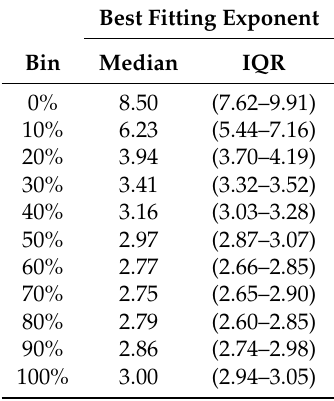
Table 1. Statistics of the obtained best fitting exponents, α bf , at each power bin of the WPP.